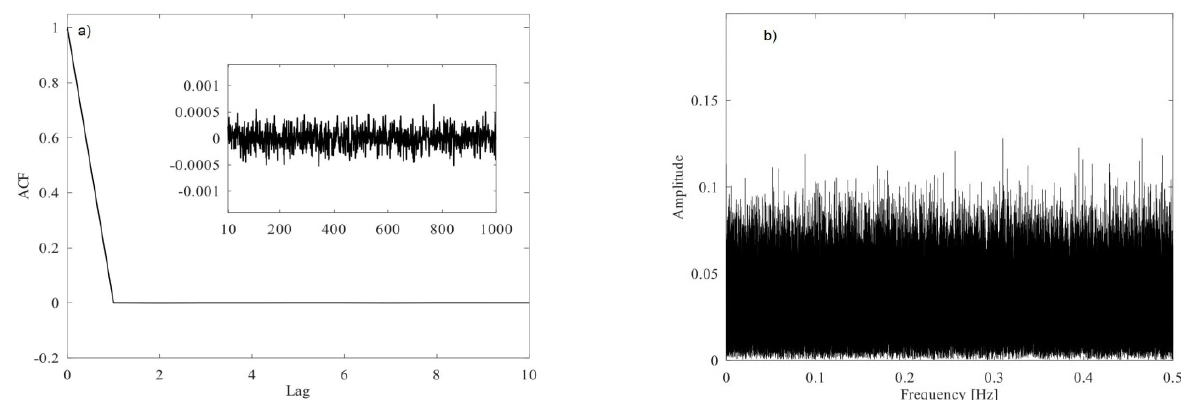
Figure 4. ( a ) Autocorrelation function of time intervals between events registered at the TOP scintillator. As shown, there is no correlation in the examined series. ( b ) Discrete Fourier transform analysis of the sequence of counts registered by detector TOP in 1 s. No significant periodicities were found. Similar results were obtained for other detectors: BOTTOM, FRONT, REAR and SIDE.